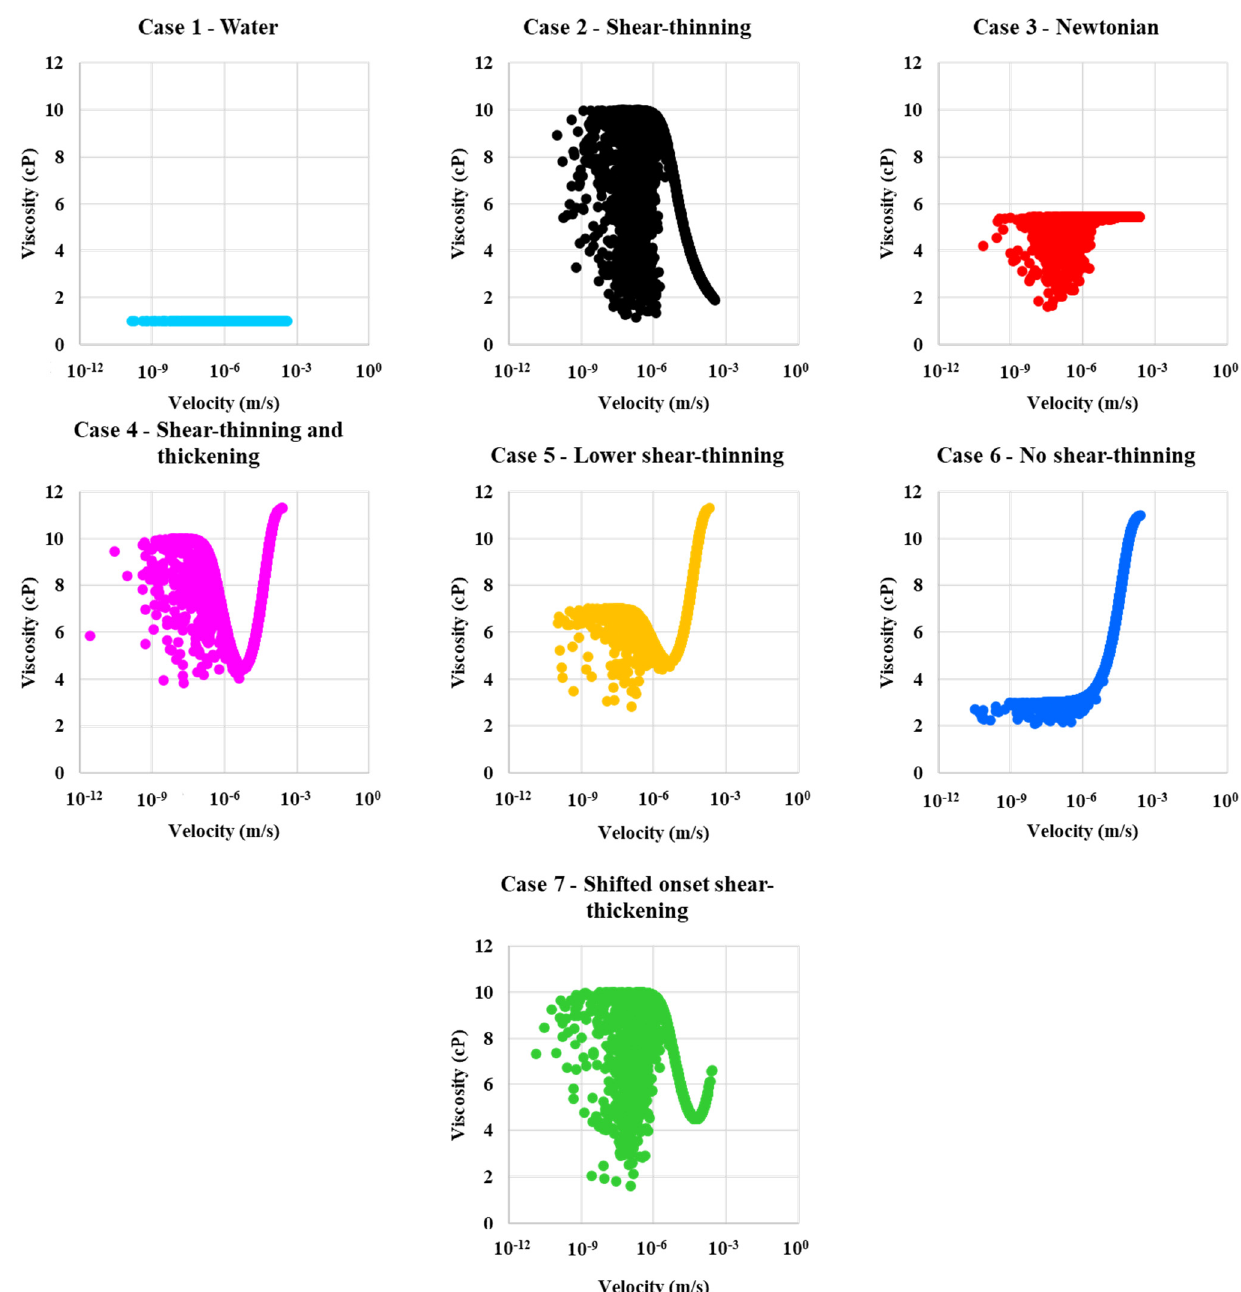
Figure 10. In-situ viscosity as a function of velocity for case 1—water, case 2—shear-thinning, case 3—Newtonian, case 4—shear-thinning and thickening, case 5—lower shear-thinning, case 6—no shear-thinning, and case 7—shifted onset of a shear-thickening polymer.